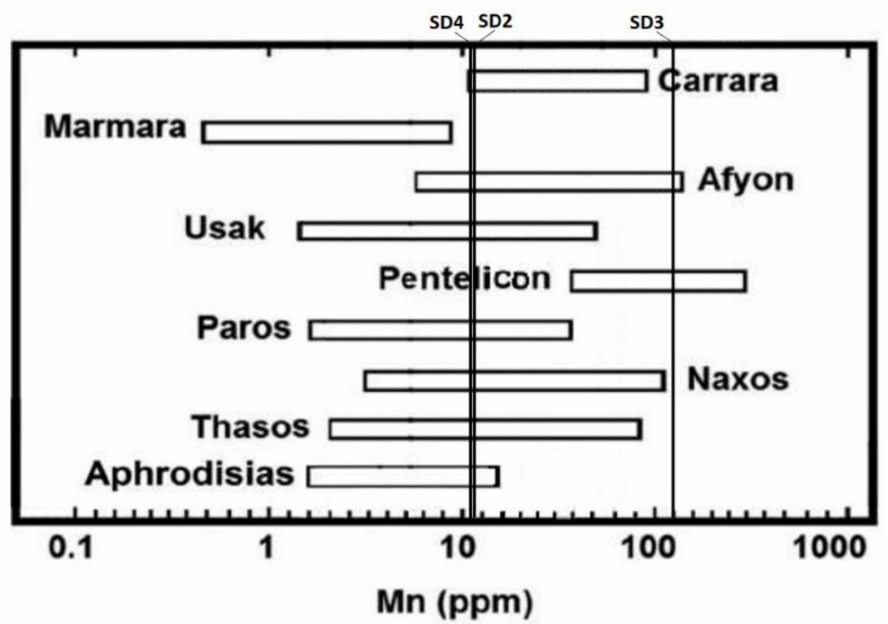
Figure 5. Diagram modified from [20] distinguishes the Mediterranean marbles based on the Mn content. Samples compositions were plotted, and their possible provenances are represented by the vertical lines crossing the different fields relative to marble districts. (Notes: Marmara = Proconnesos district; Afyon = Docimium